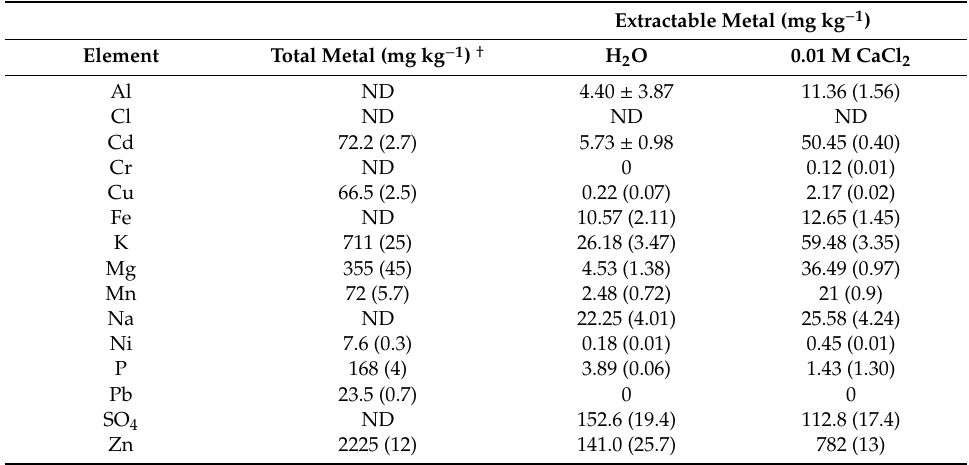
Table 1. Chemical properties of Tri-State Mine soil (C horizon) used in the